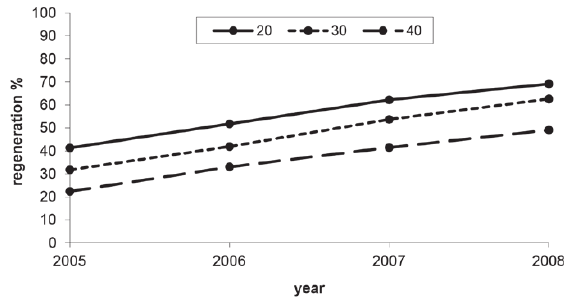
Figure 2 - Bark regeneration of Drimys brasiliensis under different percentages of exploitations (20, 30 and 40%).